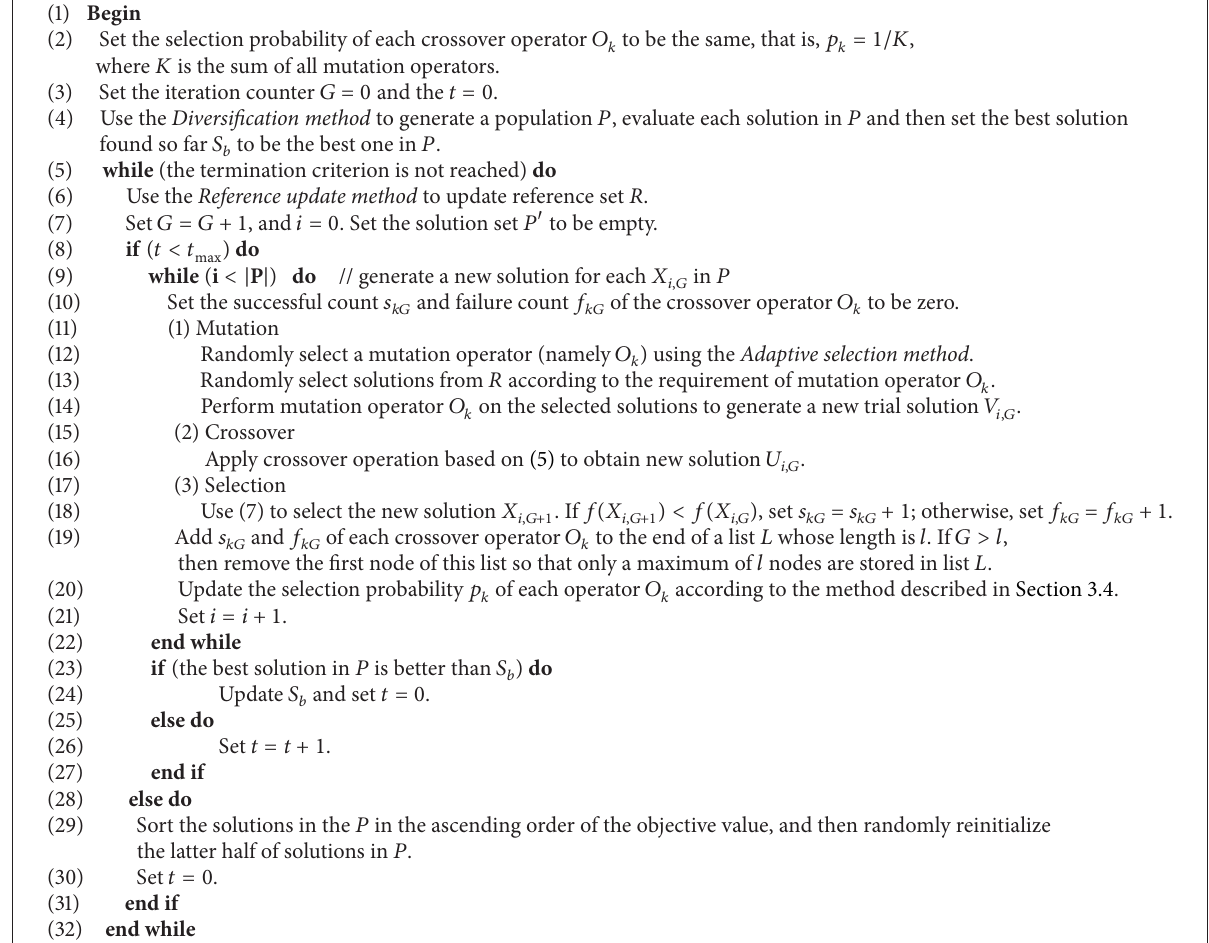
Algorithm 2: Hybrid scatter search with differential evolution